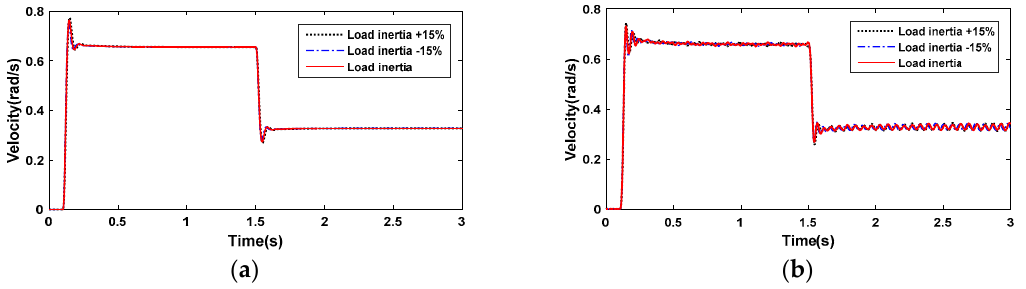
Figure 13. Robust performance to load inertia ± 15% changes with motor-side controller: ( a ) simulations; ( b ) experiments.